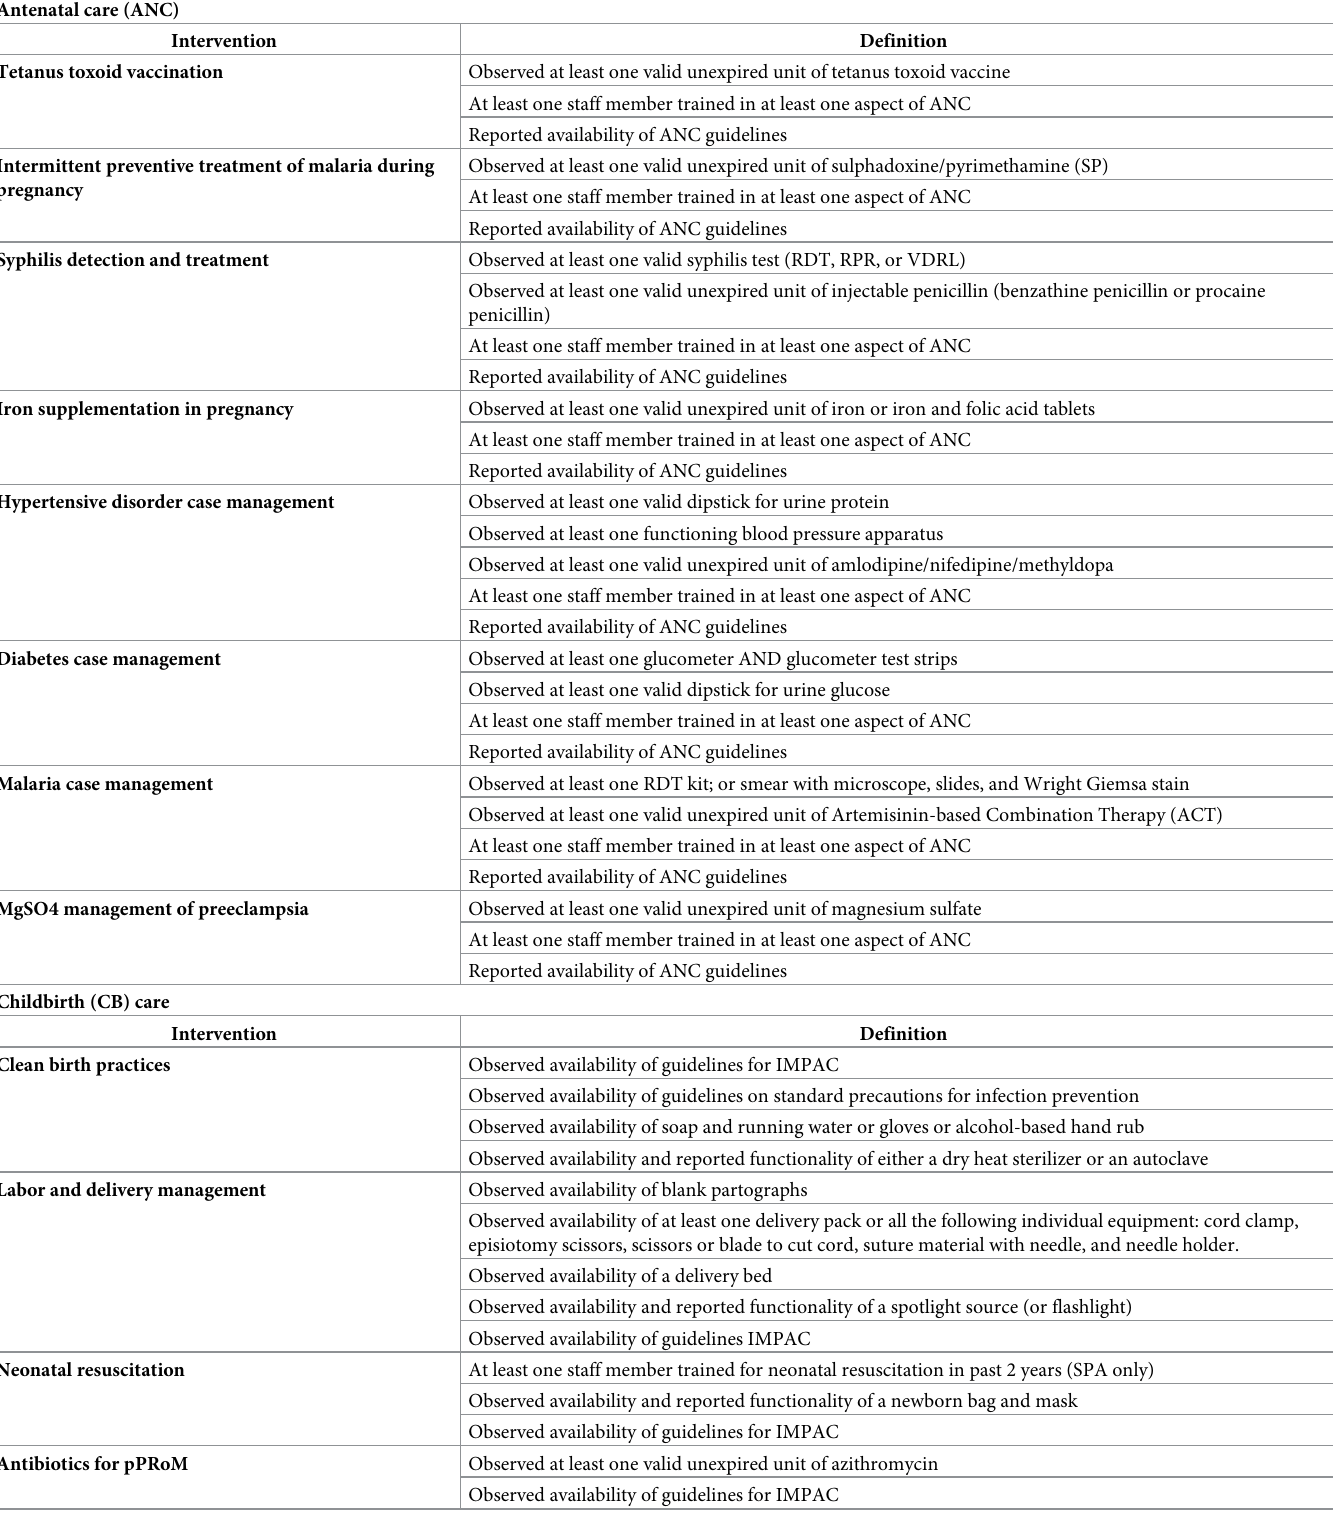
Table 2. Uniform indicator definitions applied for each